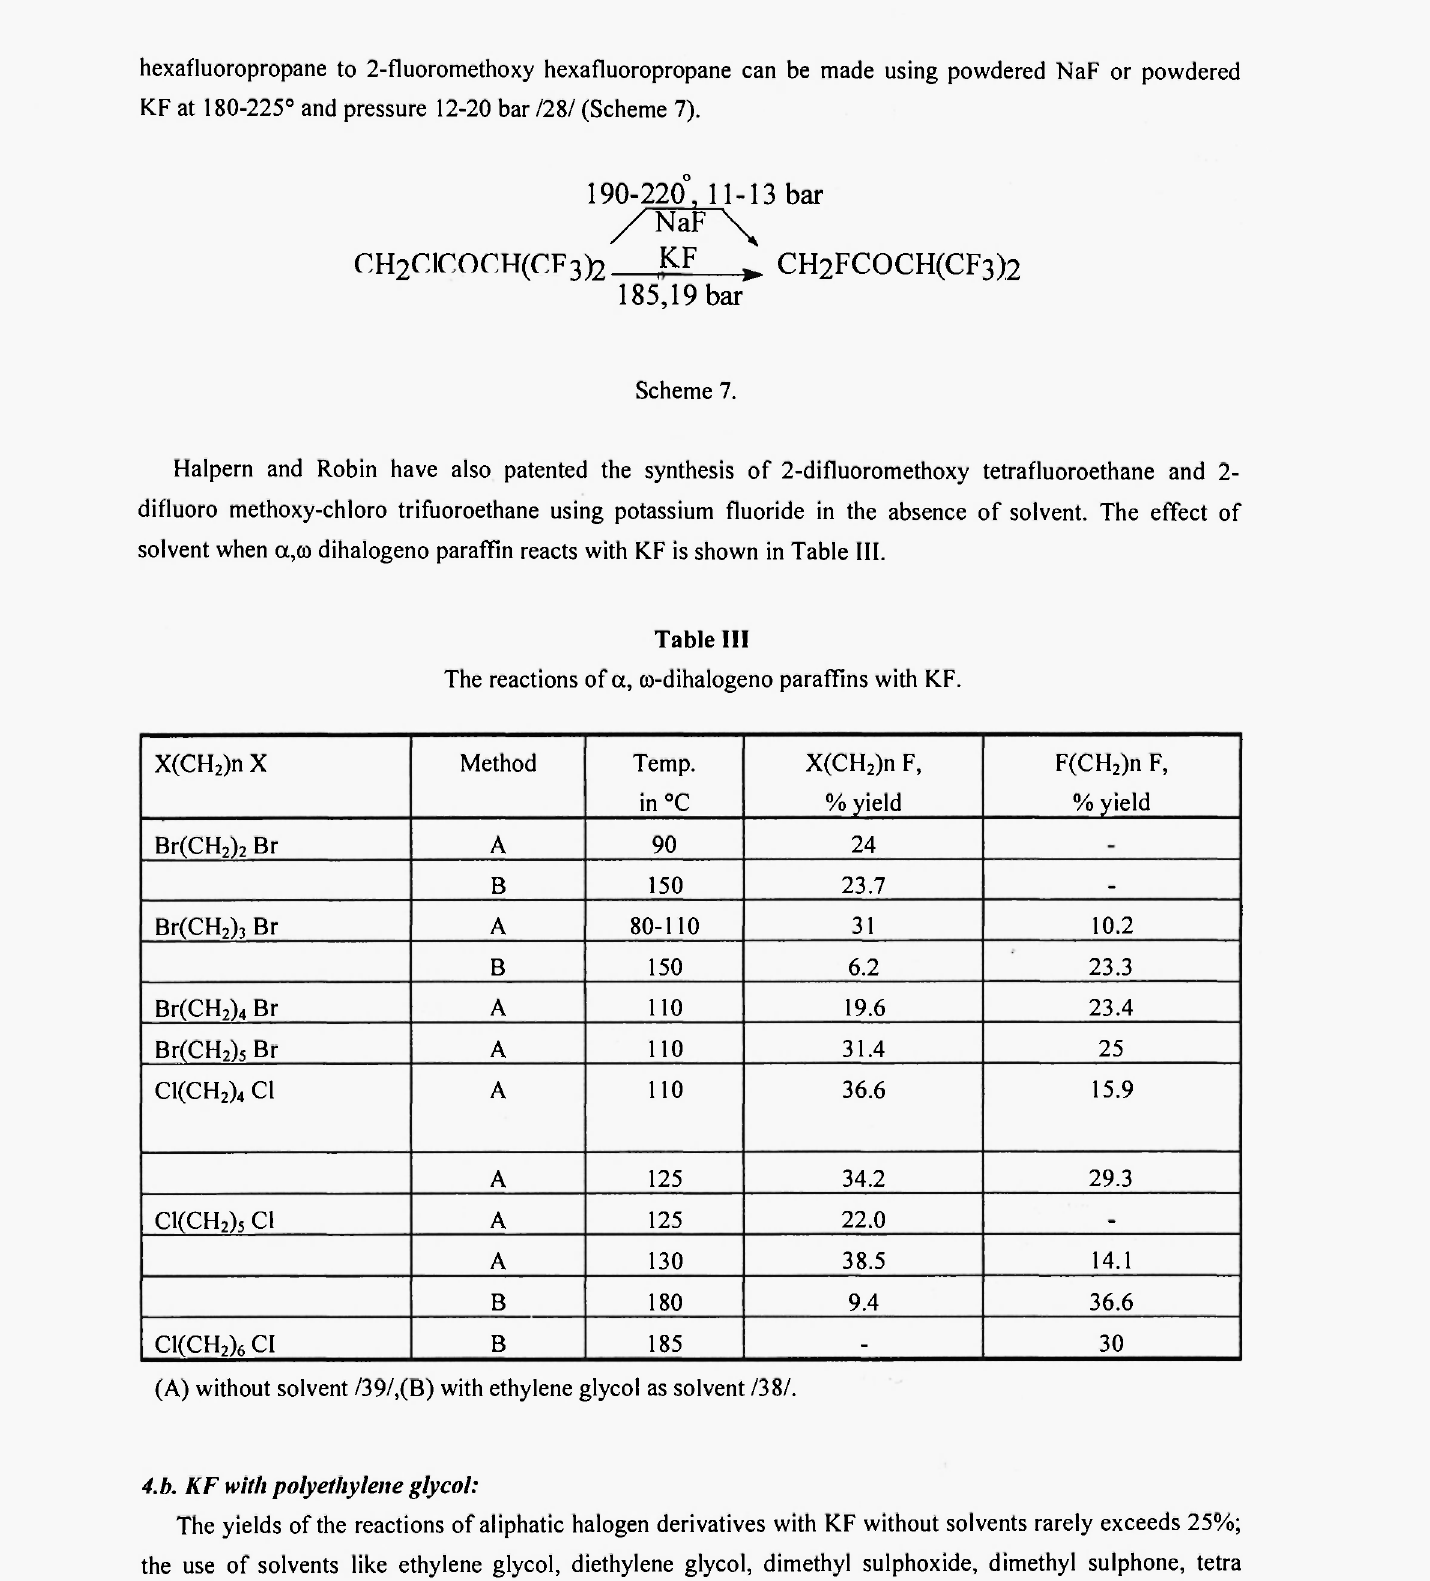
The reactions of a, ω-dihalogeno paraffins with